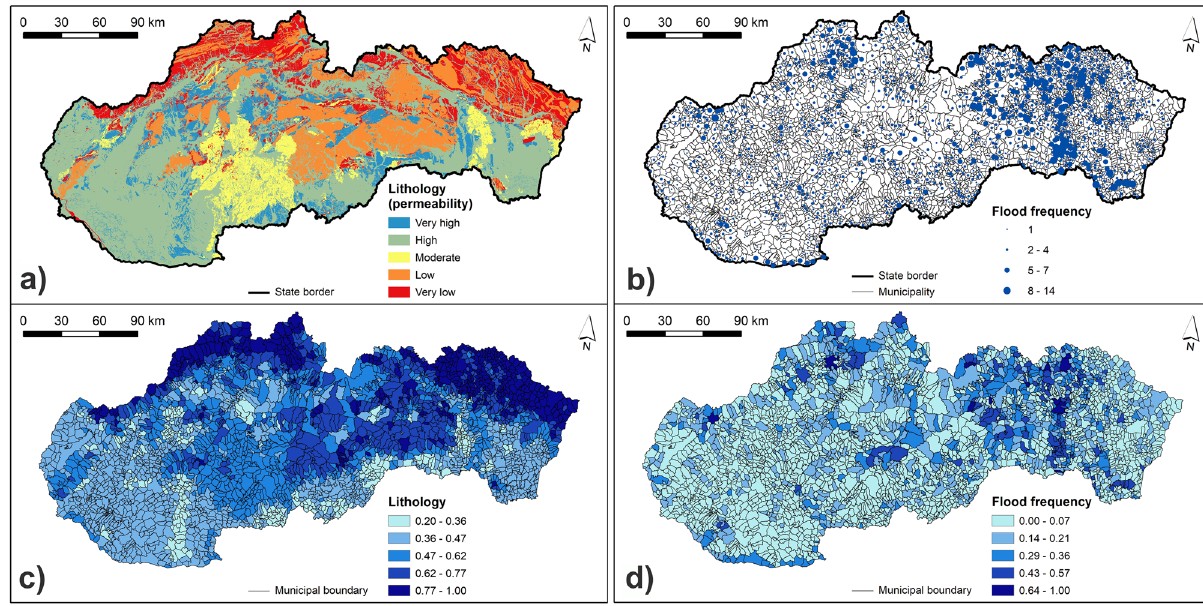
Figure 3. Lithology and number of flood events indicators: ( a ) original lithology values; ( b ) original flood frequency values; ( c ) normalized lithology values; ( d ) normalized flood frequency values. This figure was generated in ArcGIS 10.2.2